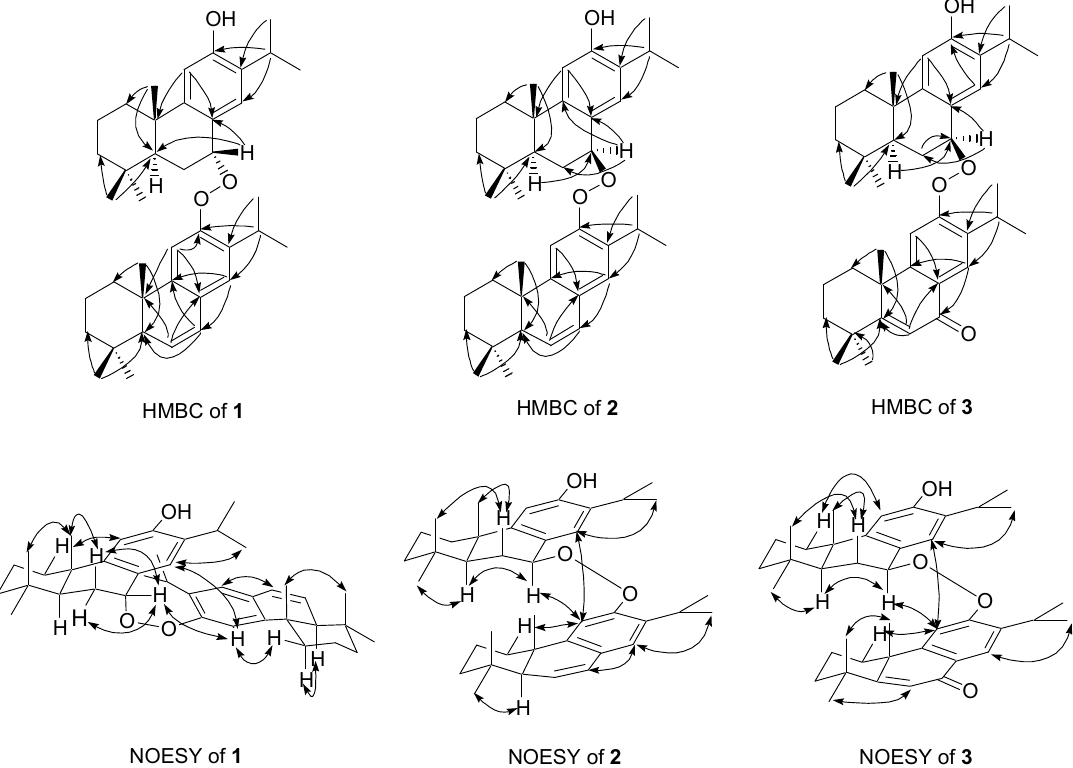
Figure 3. Significant HMBC (one-headed arrows) and NOESY (two-headed arrows) correlations of compounds 1 – 3 .